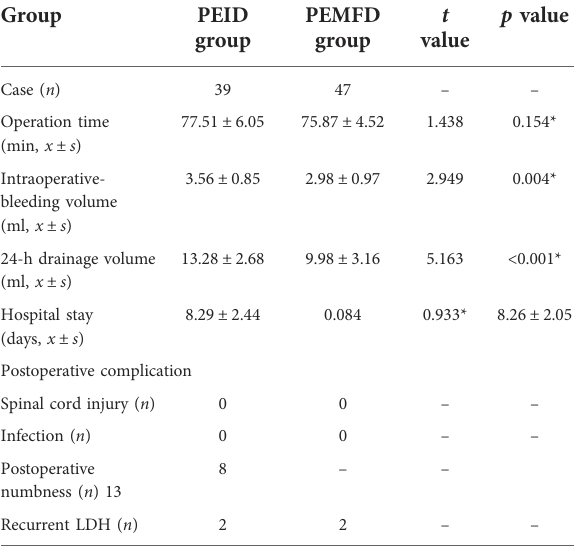
and categorical variables were compared between groups using the paired t test and Fisher ’ s exact test, respectively. p < 0.05 was considered signi fi cant.